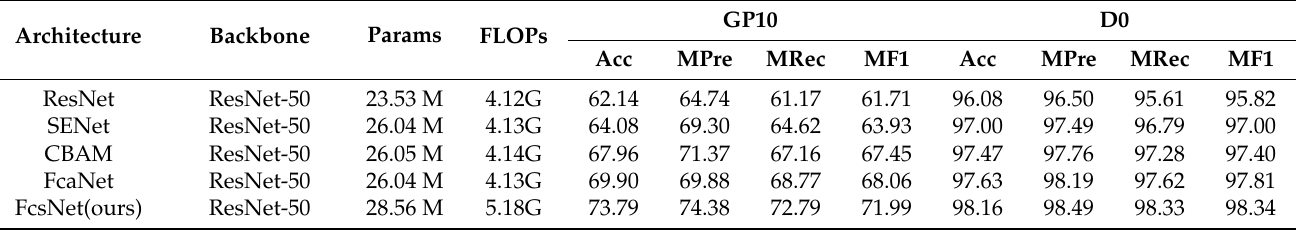
Table 3. The performance comparison of different networks on GP10 and D0